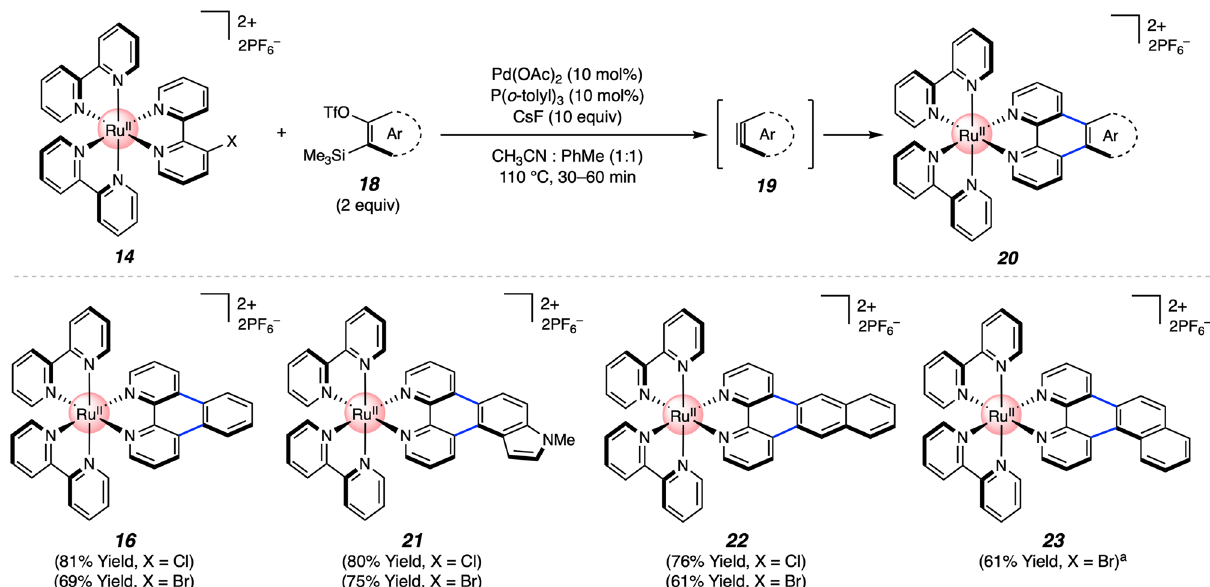
Fig. 4 Aryne scope of the Pd-catalyzed aryne annulation. Yields shown re fl ect the average of two isolation experiments. a Signi fi cant decomposition was observed when X = Cl. Me, methyl; OTf, tri fl uoromethanesulfonate.